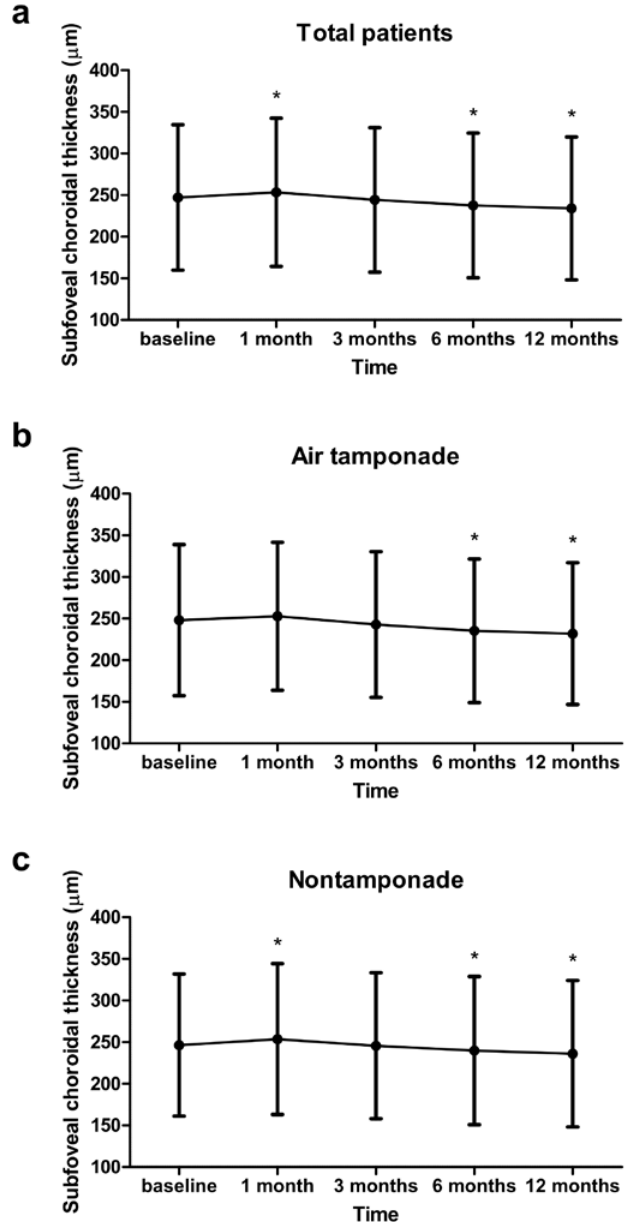
Figure 1. Changes in subfoveal choroidal thickness over 1 year. ( a ) Total patients, ( b ) air tamponade group, and ( c ) nontamponade group. There was no significant difference between the two groups at 1 year. In both groups, the subfoveal choroidal thickness significantly decreased at 6 months and 1 year after the operation compared with the preoperative values. * p < 0.05 by paired t -test.